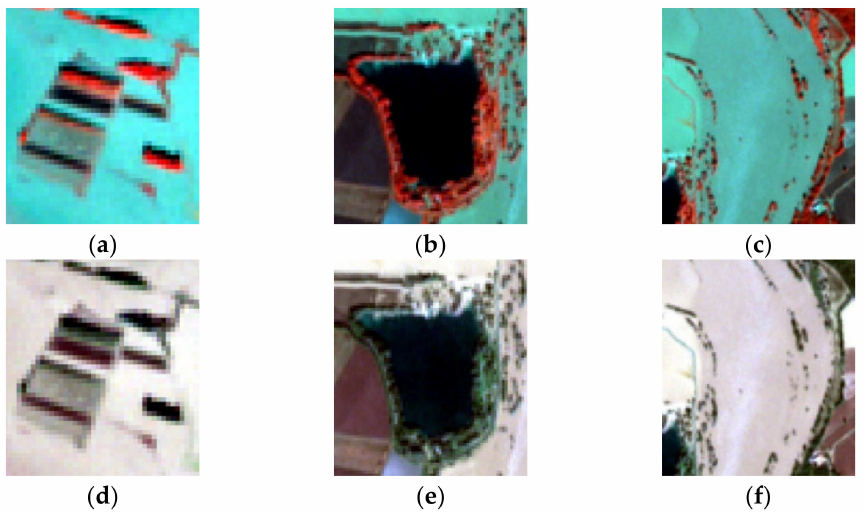
Figure 4. First row: Example of false color composites (R = S2 band 8(NIR), G = S2 band 3 (Green), B = S2 band 2 (Blue)) over ( a ) emergent vegetation (EV), ( b ) clear water (CW) and ( c ) turbid water (TW) classes. Second row: example of true color composite (RGB) over ( d ) emergent vegetation, ( e ) clear water, and ( f ) turbid water classes.